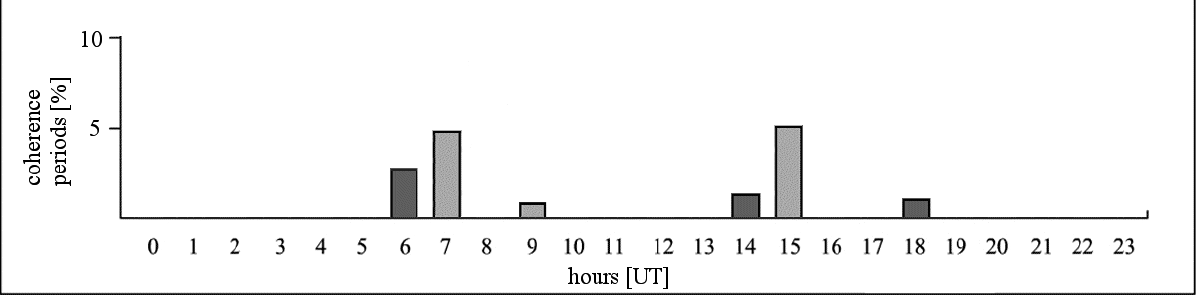
Figure 11. Percentage of occurrence of coherence for periods of 190-210 s calculated with the threshold values T